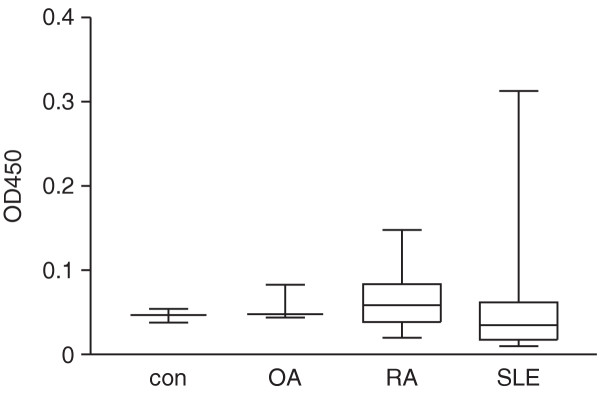
CXCL10 concentrations in sera. Sera of healthy controls and of patients with rheumatoid arthritis, systemic lupus erythematosus and osteoarthritis were tested in a standard ELISA test. A D450 of 0.06 corresponds to 200 pg/ml CXCL10 (concentration after Ficoll centrifugation); for each of the groups analyzed median values are indicated. Con, control; OA, osteoarthritis; RA, rheumatoid arthritis; SLE, systemic lupus erythematosus.